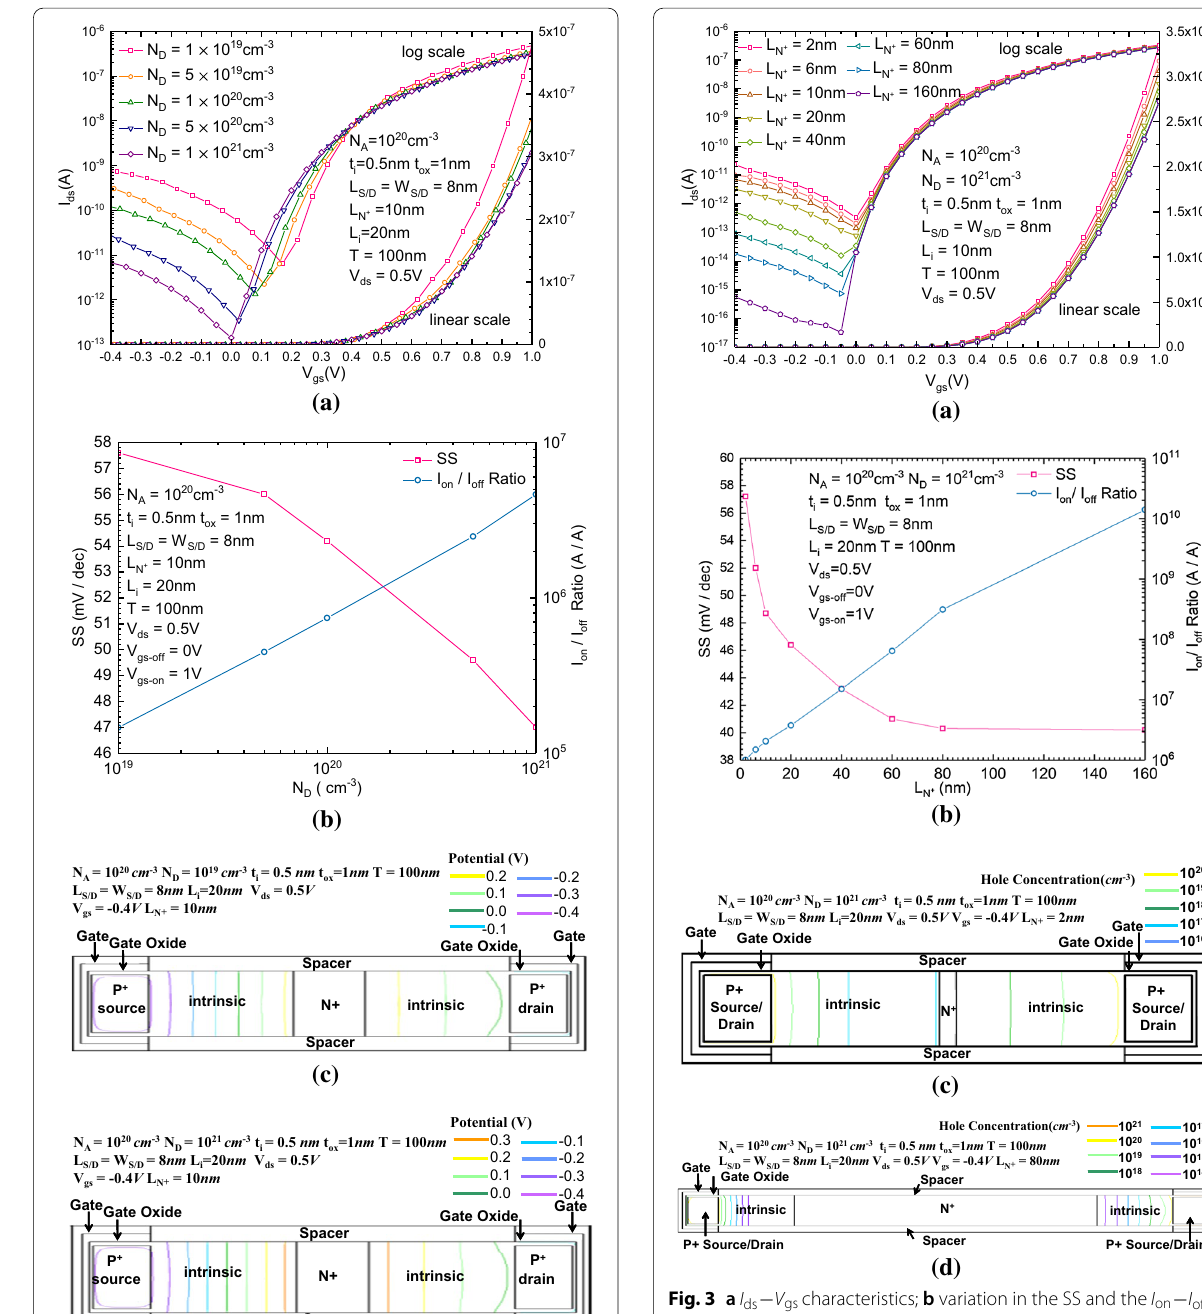
; 2‑dimensional hole +